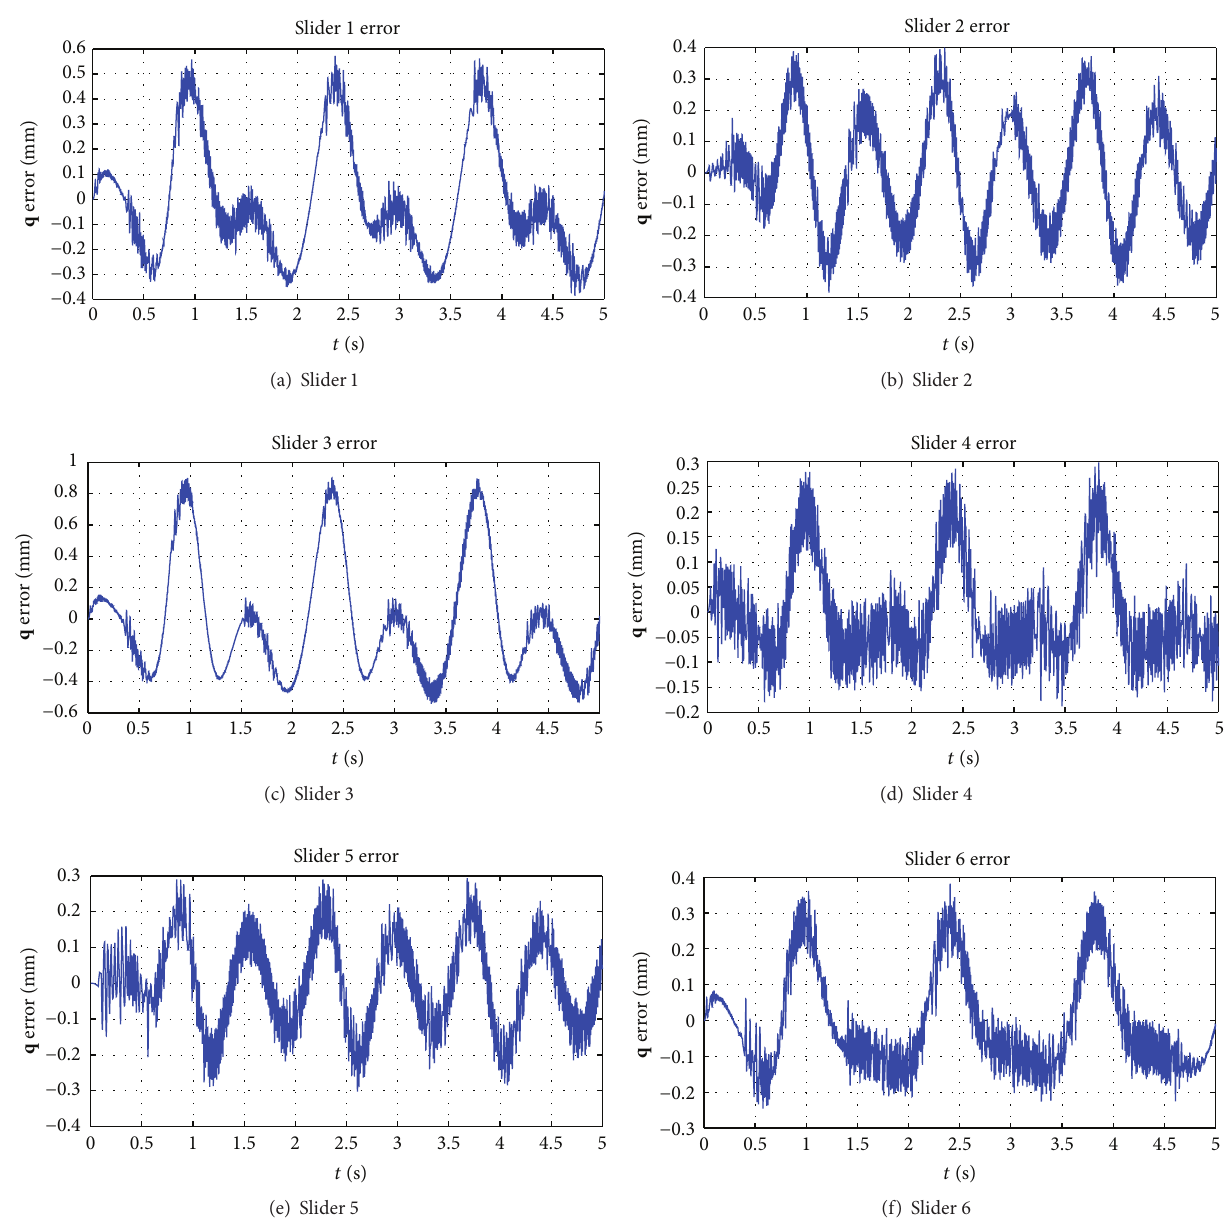
Figure 10: Position errors of the sliders when adaptive-robust control is